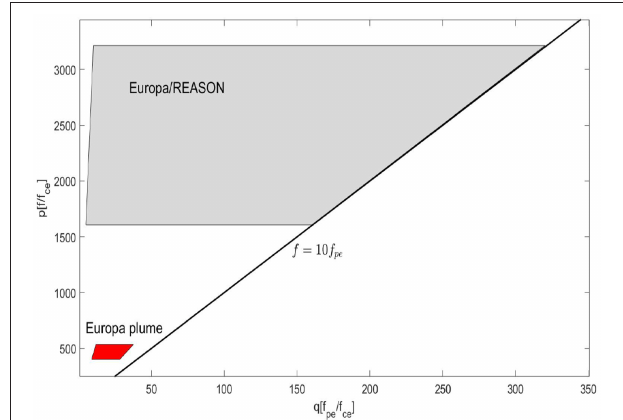
FIGURE 7 | Expectations of the SAP in the ionosphere of Venus. The gray area shows the range of the p − q parameters for the expected Venus environment and SRS sounding characteristics. The areas encircled by red and blue indicate the possibility of the SAP detection.